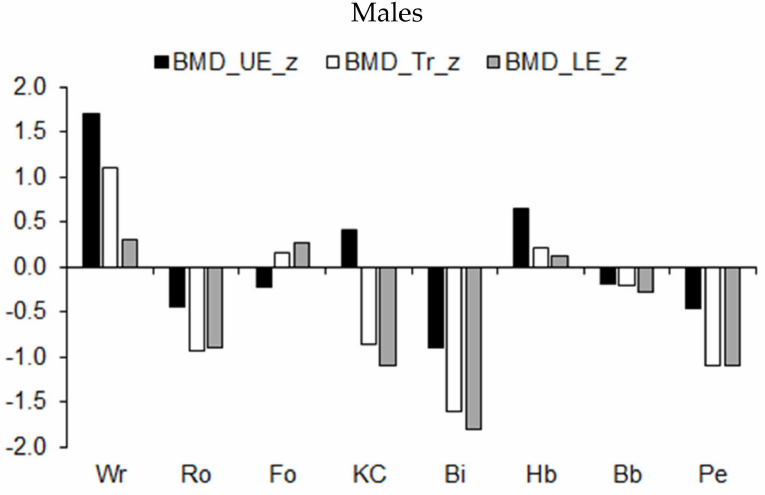
Figure 7. BMD of upper extremities (UE), trunk (Tr), and lower extremities (LE) expressed as a percentage of total BMD by age in youth male and female athletes (Mann–Whitney test: UE— p < 0.05 in 13, 14, and 19 years of age; Tr— p < 0.05 in 13, 14, and 16 years of age; Le— p < 0.05 in the entire